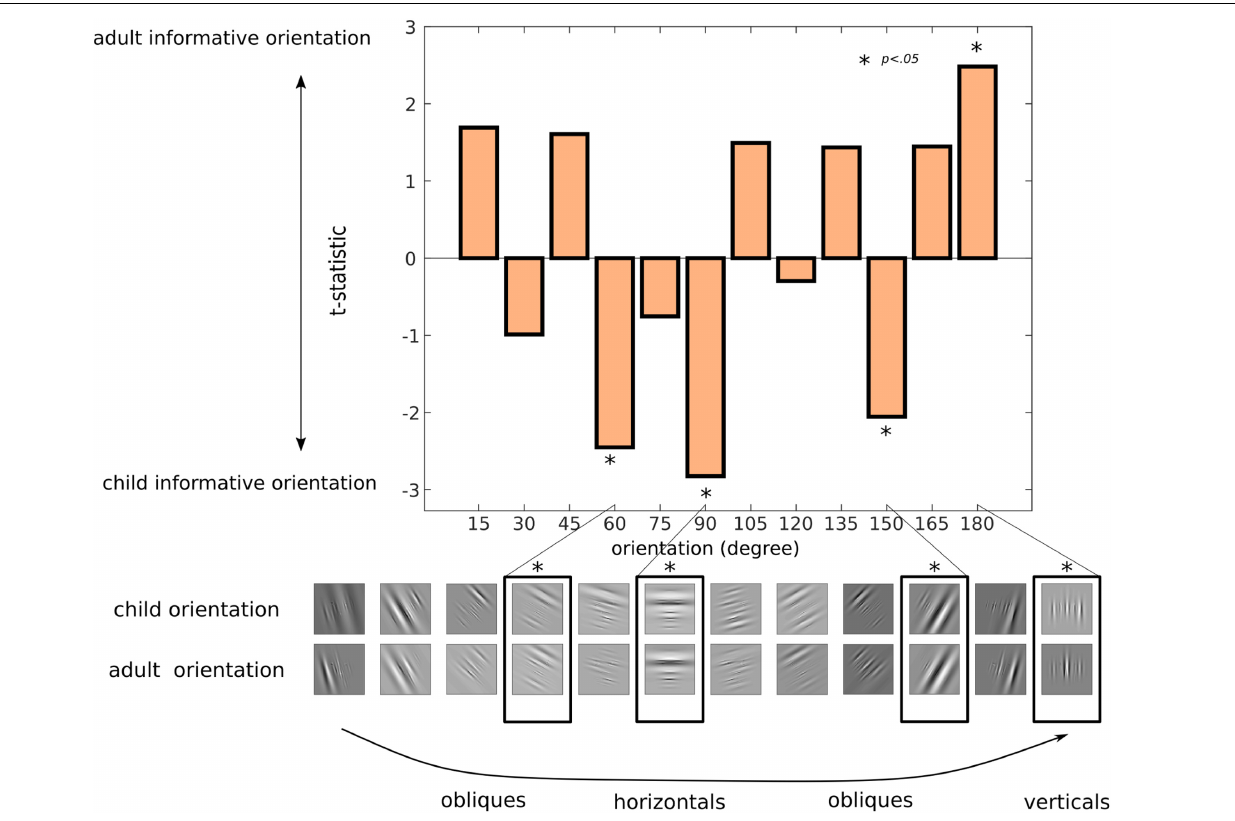
FIGURE 4 | What orientation structure do we rely on to categorise child and adult faces? Correlations coefficients for feature orientation (for accurate classification of child and adult images) were compared between child and adult faces for each one of the 12 orientation bands (10 ◦ –180 ◦ in 15 ◦ steps) with unpaired t -tests. For visualisation purposes, the lower panel images display the facial information for each of the 12 orientation bands for child and adult faces. Positive t -statistics shows orientation evidence for child-like faces, while negative values shows orientation evidence for adult-like faces. Significant orientation bands – horizontal (90 ◦ ) and oblique (60 ◦ and 150 ◦ ) information for child faces, vertical information (180 ◦ ) for adult faces – are outlined with an